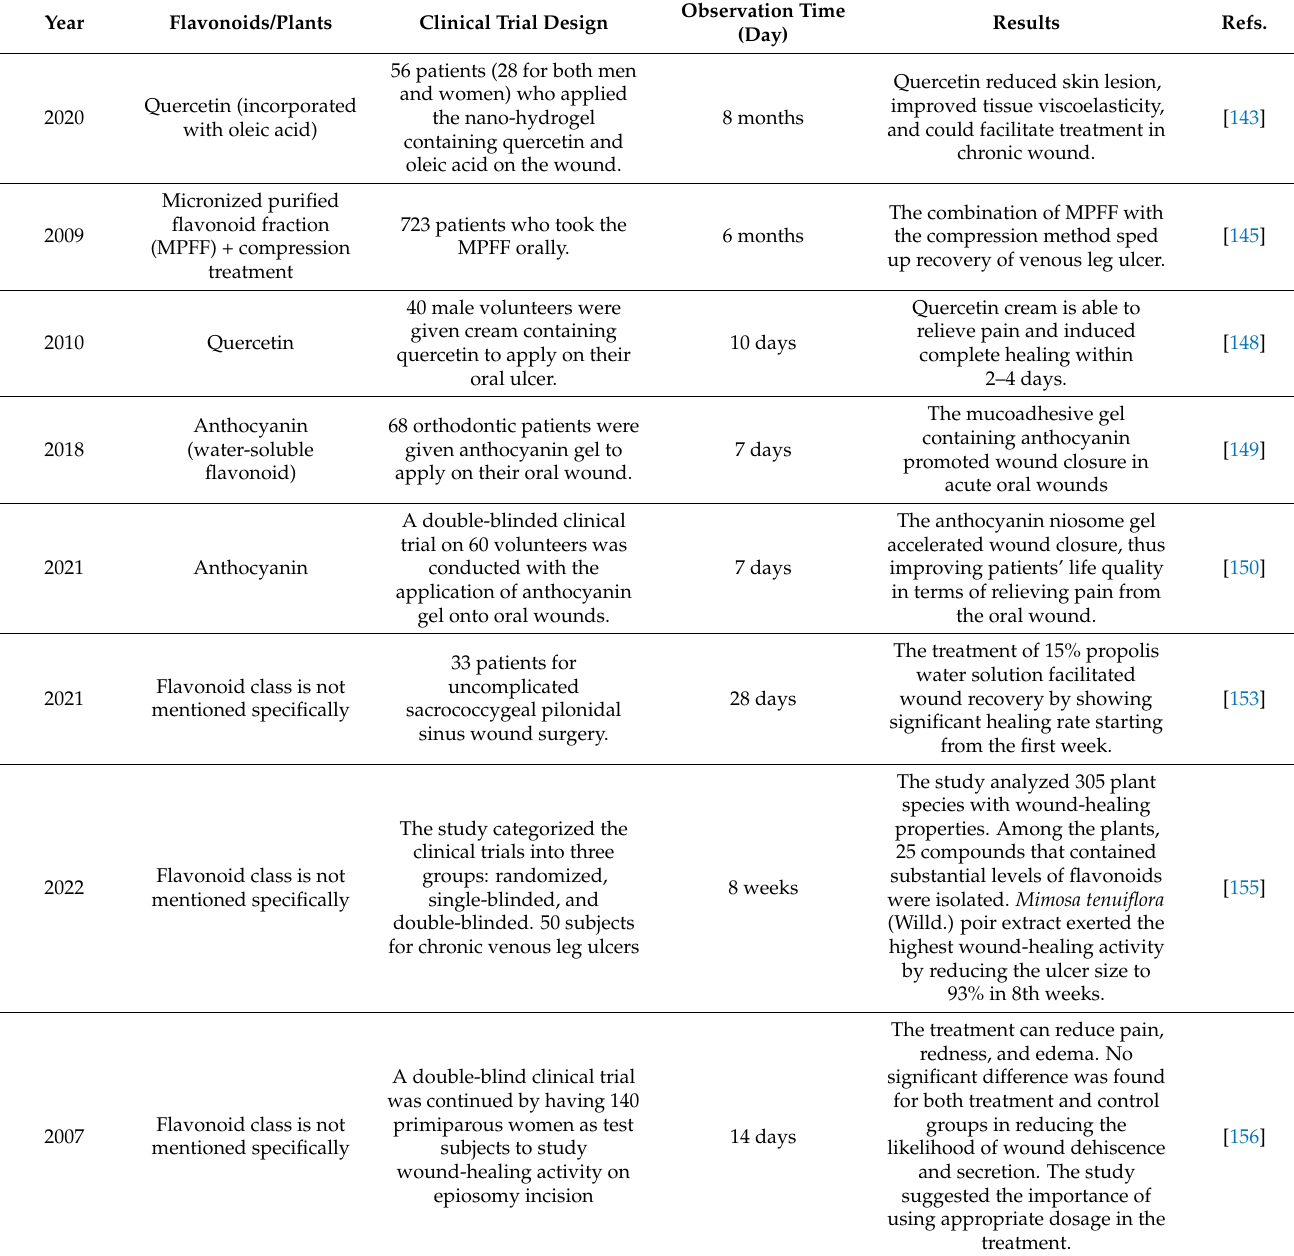
Table 5. Summary of flavonoids on wound-healing clinical